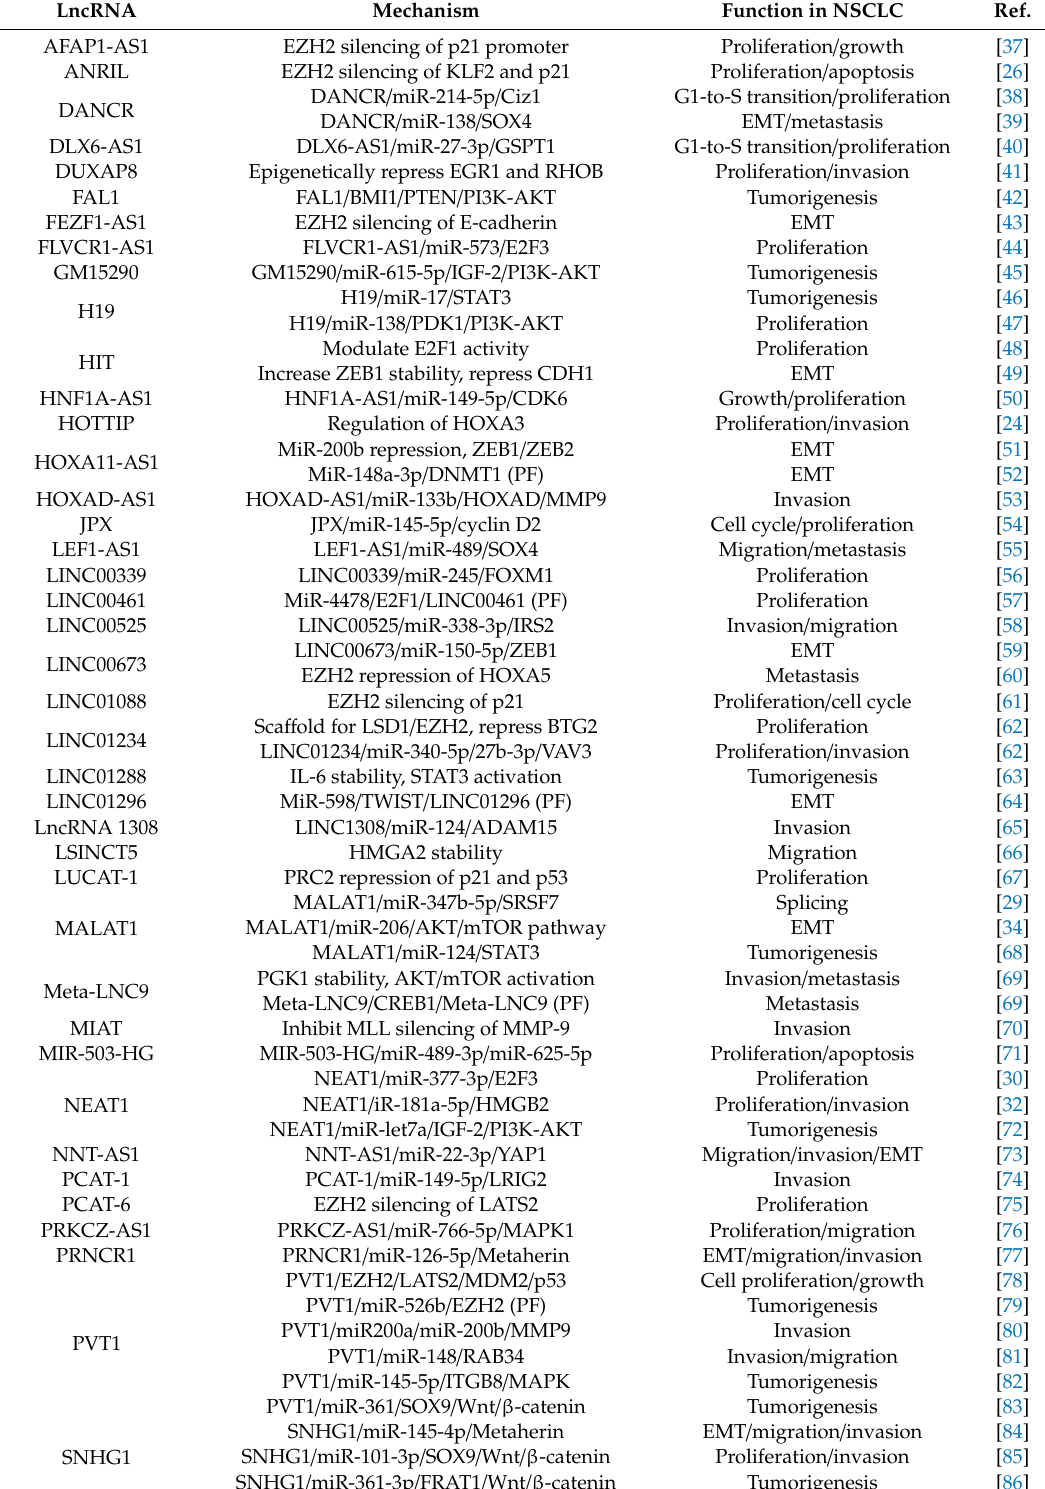
Table 1. Oncogenic lncRNAs upregulated in non-small-cell lung cancer